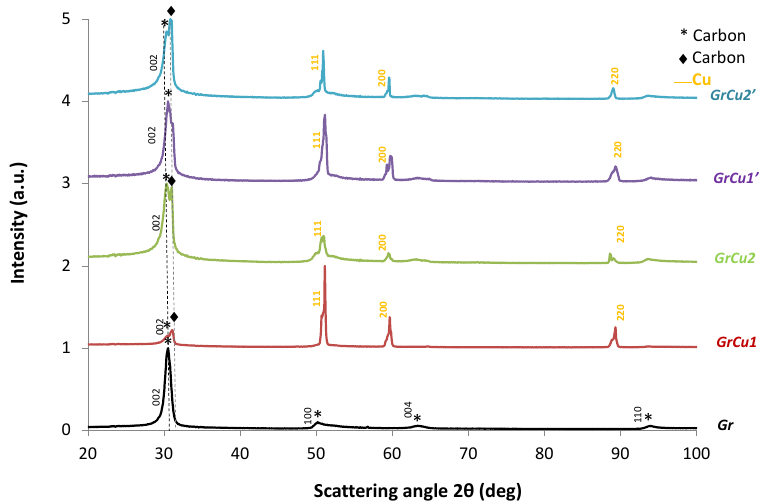
Figure 8. X-ray di ff raction patterns of Gr and GrCu samples synthesized following the experimental Figure 8. X-ray diffraction patterns of Gr and GrCu samples synthesized following the experimental conditions of Table 1, taken with Cobalt-K α radiation ( λ = 1.7889 conditions of Table 1 , taken with Cobalt-K  radiation (  = 1.7889 Å ). Table 3. Copper and zinc oxide peak positions, lattice parameters and crystallite sizes obtained from X-ray diffraction patterns of graphene hybrids GrCu and GrZnO.